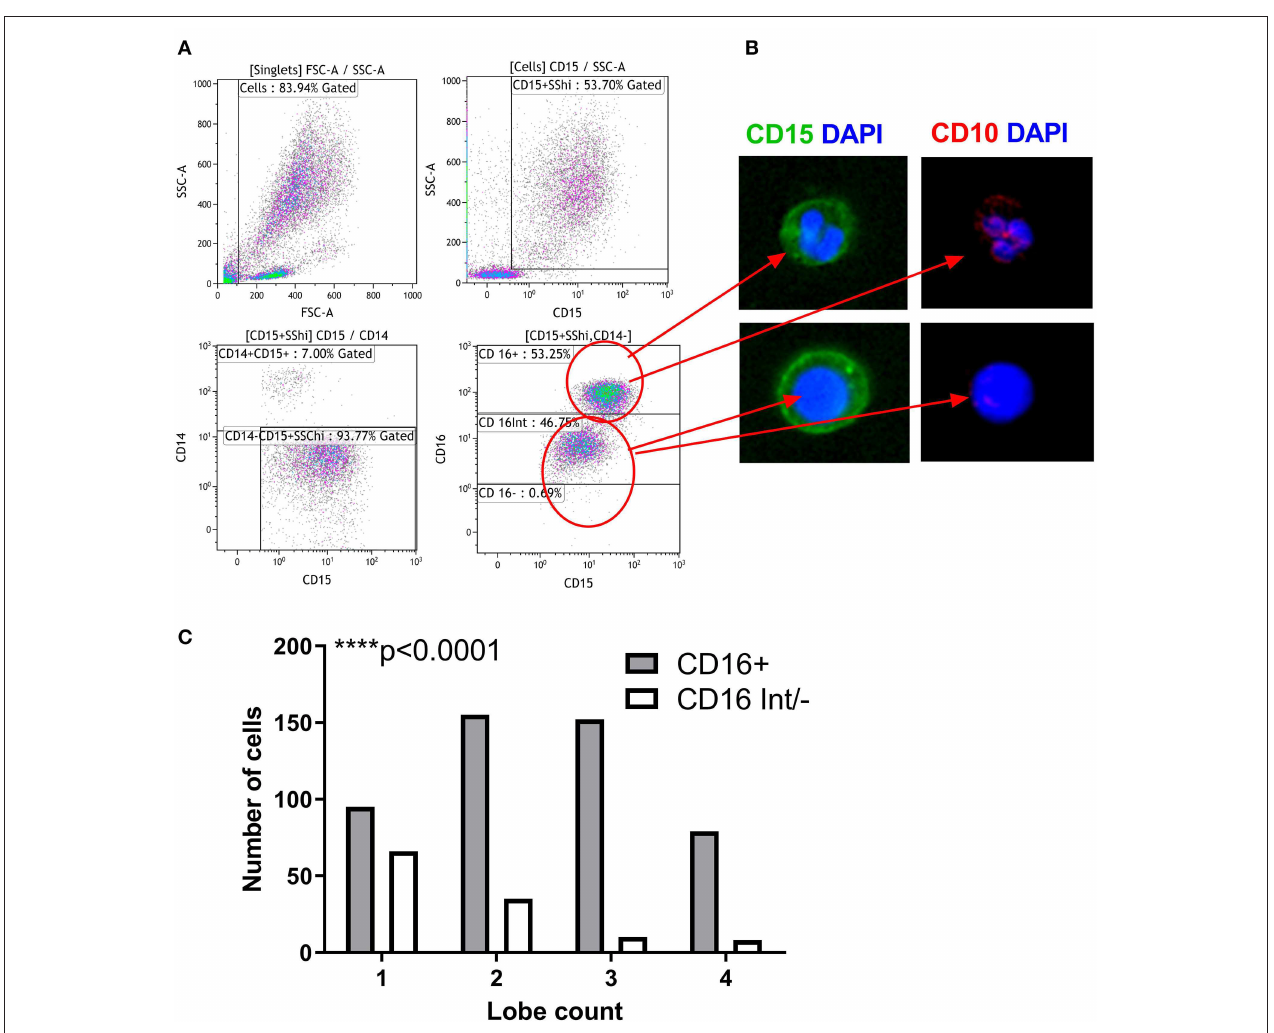
FIGURE 4 | Nuclear Morphology defines the maturity of LDG subsets. Gating strategy for identification of LDG subsets by imaging flow cytometry: after gating on SSC hi CD15 + CD14 − singlets, LDG subsets were defined as CD16 + and CD16 int / − . (A) Representative images of LDG subsets shown. Images obtained at 60x magnification on ImageStream X MkII using DAPI nuclear stain (blue), CD15 (green), and CD10 (red). Merged images show the multilobed CD16 + population and the circular/kidney-shaped nuclei of the CD16 int / − population and the CD10 staining of the CD16 + subpopulations. (B) LDG subsets can be defined by their nuclear lobe count, a marker of granulocyte maturity. CD16 + LDGs have predominantly multilobed nuclei while CD16 int / − have mostly single lobed nuclei. Chi square test (C) . **** p < 0.0001.